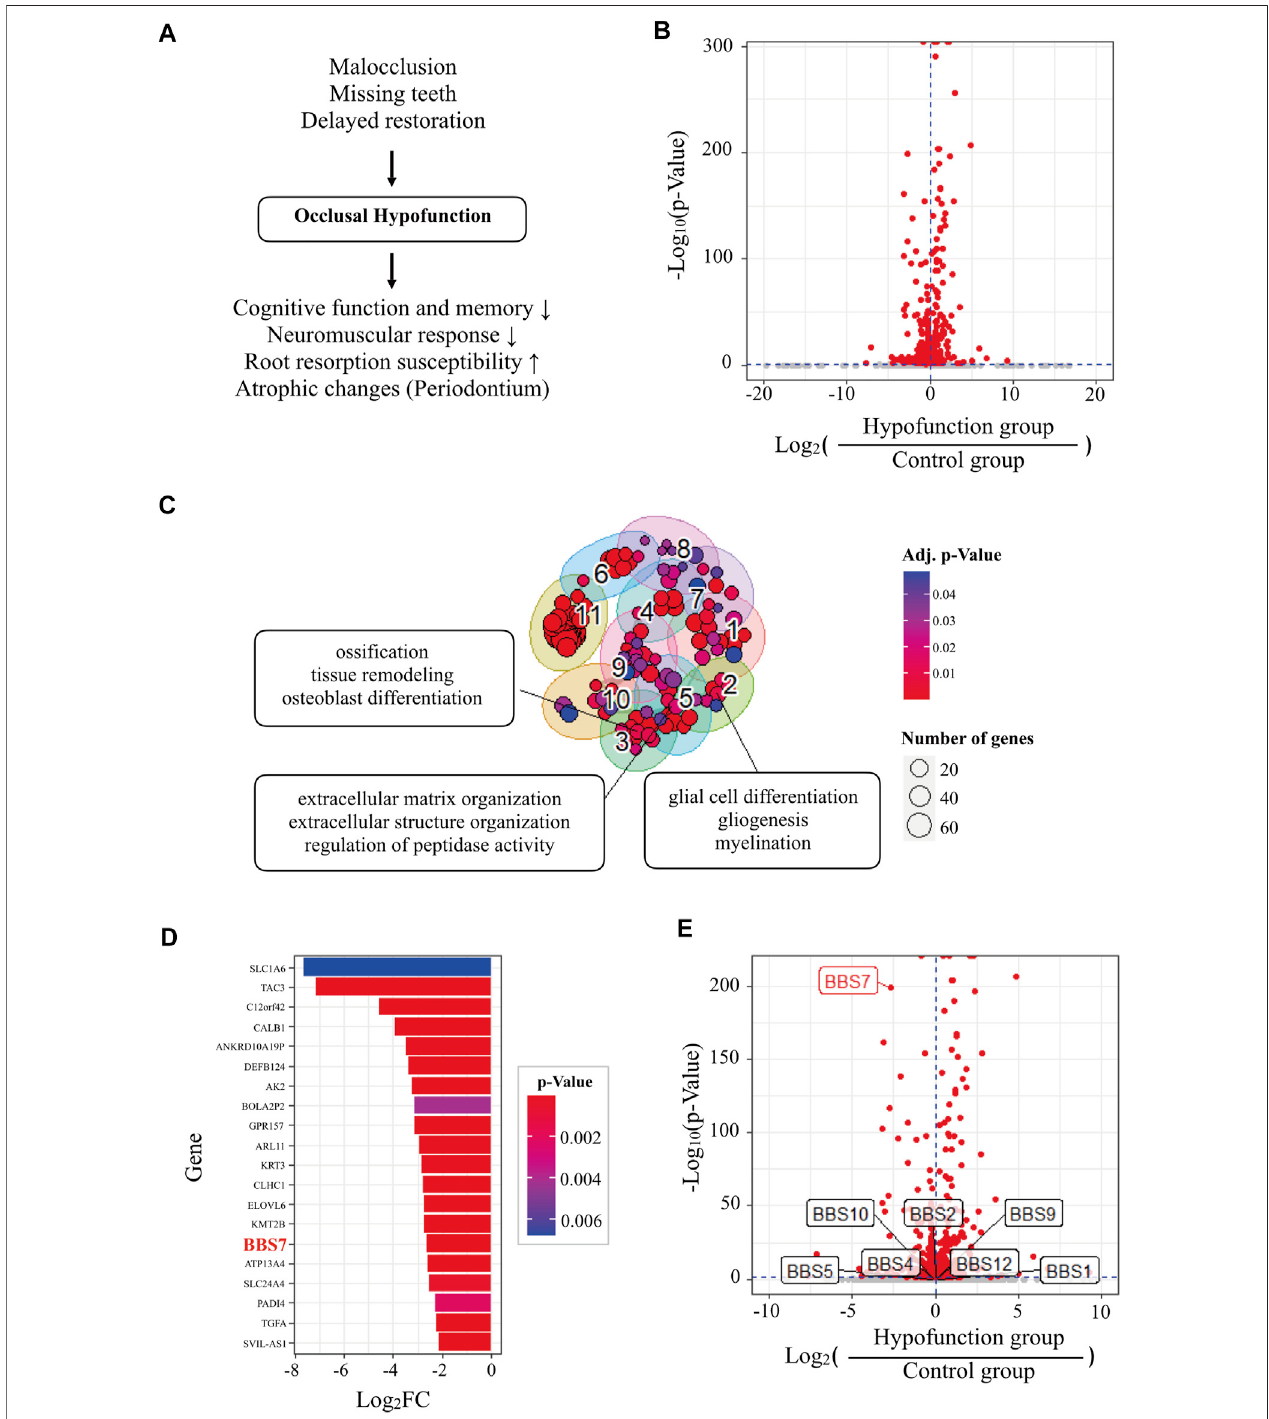
FIGURE 1 | Transcriptome analysis of human PDL tissue in normal and occlusal hypofunctional tooth. (A) The diagram of the cause and the clinical implications of occlusal hypofunction. Lack of occlusal contact induced the occlusal hypofunction which is caused by missing and abnormal positions of teeth or other diseases. It resultsinvariousatrophicchangesintheperiodontiumtissues,decreasedneuromuscularresponse,andincreasedrootsusceptibility,andalsoaffectscognitivefunction and memory. (B) Volcano plot of differentially expressed genes (DEGs) of hypofunction samples compared with control samples. Horizontal and vertical dashed blue lines indicate p value (cid:1) 0.05 and fold change (cid:1) 0, respectively. Red dots indicate signi fi cant ( p value < 0.05) DEGs. (C) Gene ontology (GO) cluster map of signi fi cantly downregulated DEGs. Three top-ranked terms consisted of interesting GO clusters that were selectively labeled. Adj. p value (cid:1) adjusted p value by the Benjamini-Hochberg (BH) method. (D) Top 20 genes of signi fi cantly downregulated DEGs. (E) Volcano plot of DEGs labeled with Bardet-Biedl syndrome ( BBS ) genes.